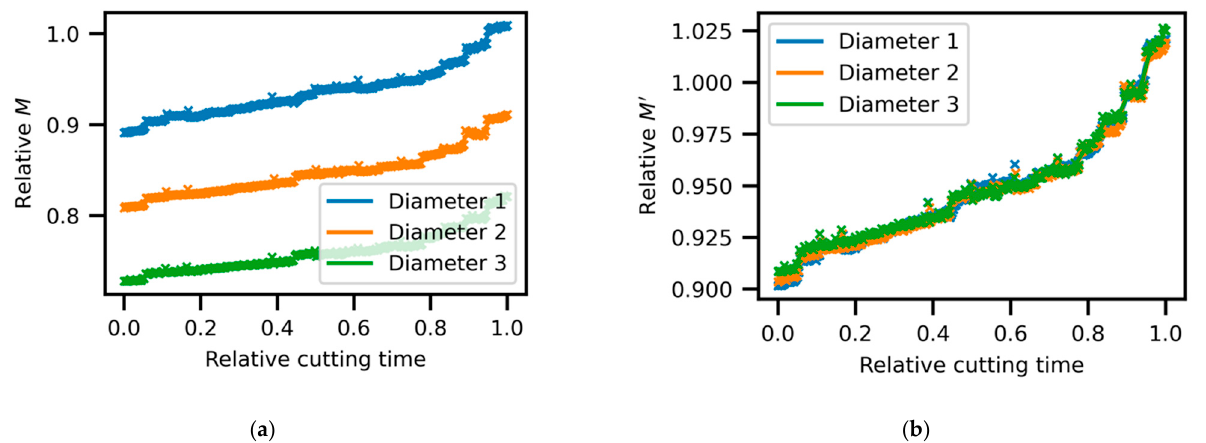
Figure 4. By refactoring the spindle torque signal ( a ) to the normalized spindle torque ( b ), the signal impact of cutting at various diameters can be compensated.